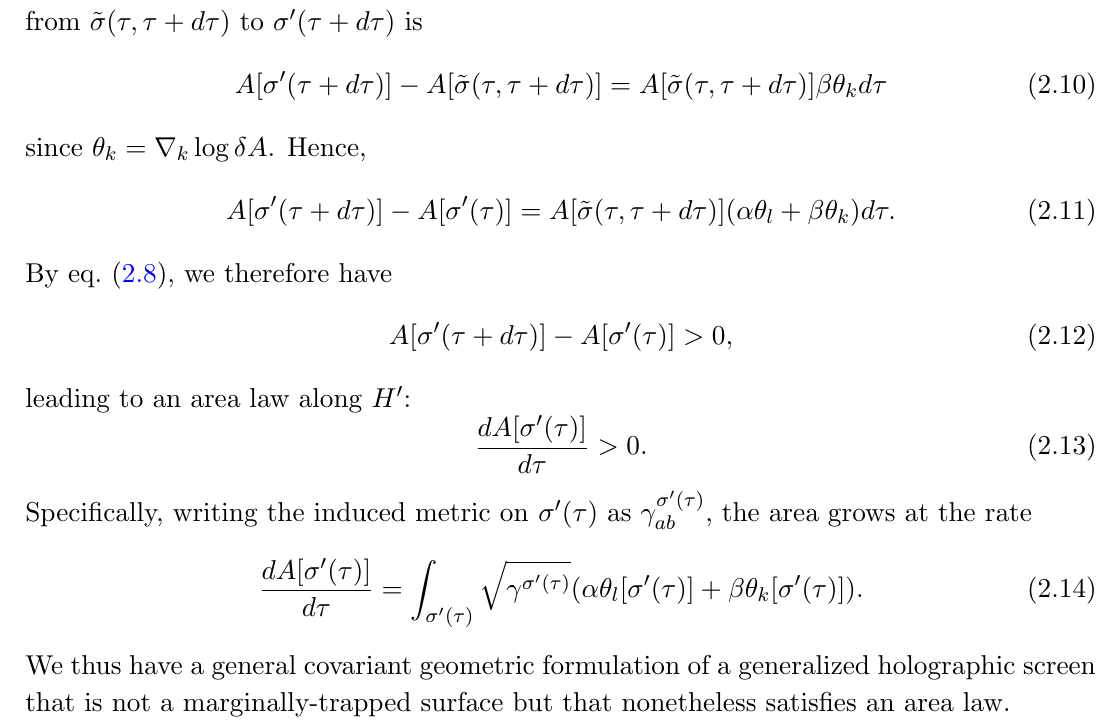
Figure 3 . Zigzag construction proving the area law on a generalized holographic screen H curve). From (cid:27) 0 ( (cid:28) ) (examples given by orange dots), we take the past l light sheet N (orange lines), while from (cid:27) 0 ( (cid:28) + d(cid:28) ) (green dots), we take the k light sheet N k ( (cid:27) 0 ( (cid:28) + d(cid:28) )) (green lines). The intersection ~ (cid:27) ( (cid:28); (cid:28) + d(cid:28) ) (black dots) is always nonempty. We have A [~ (cid:27) ( (cid:28); (cid:28) + d(cid:28) )]